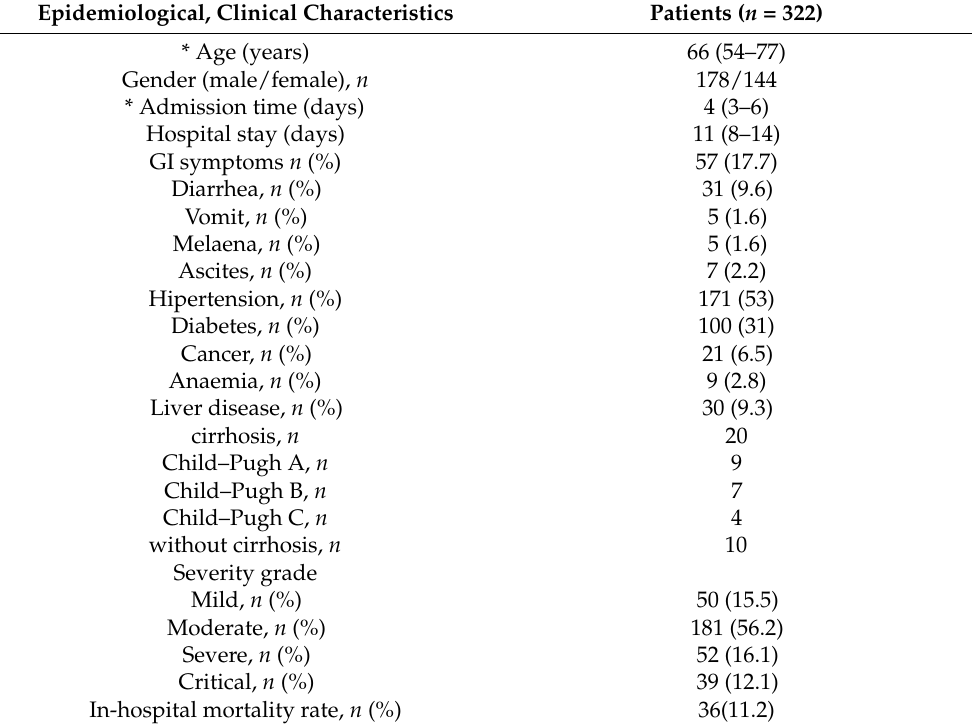
Table 1. Epidemiology, clinical characteristics, and severity grade of 322 COVID-19 patients admitted to the Semmelweis University Department of Surgery, Transplantation, and Gastroenterology between